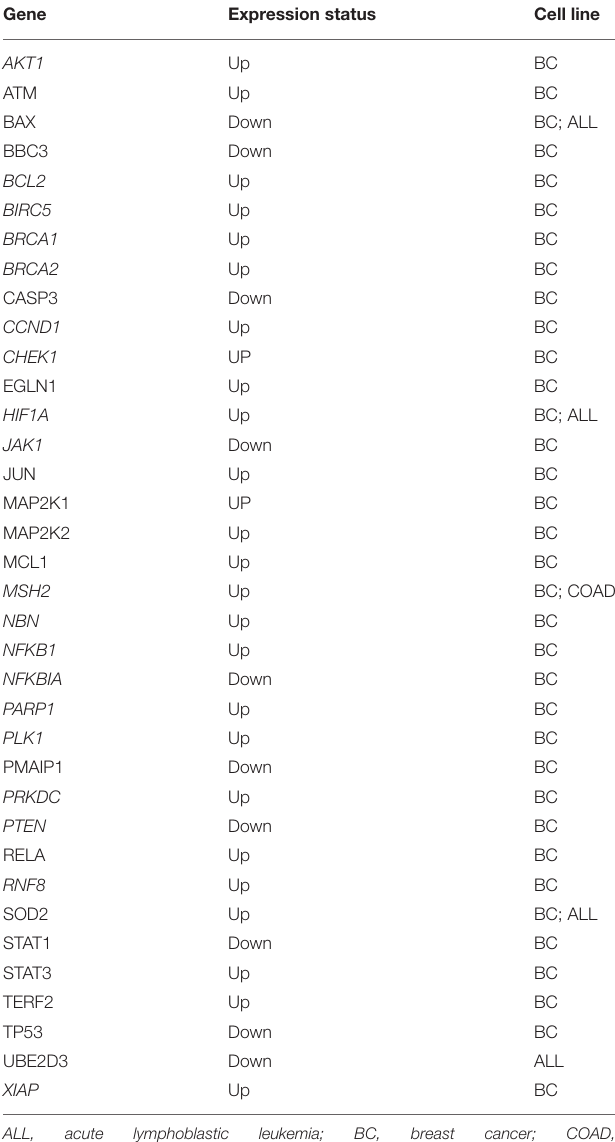
clustered damaged sites is quite challenging since the presence of a lesion in one strand can delay significantly the simultaneous processing of another lesion on the complementary